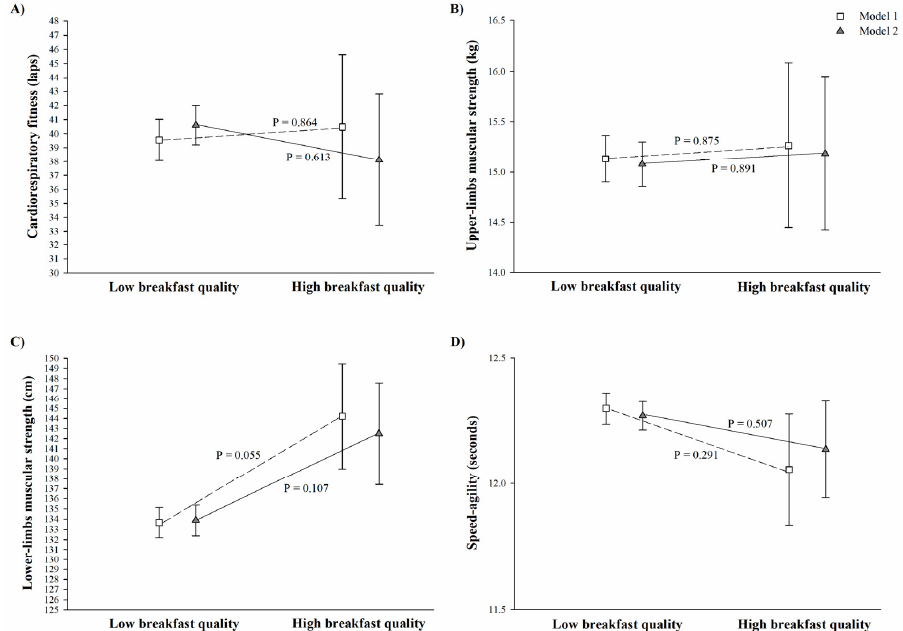
Figure 2. Differences between low and high breakfast quality and physical fitness components in children ( Panel A : cardiorespiratory fitness, Panel B : upper-limbs muscular strength, Panel C : lower-limbs muscular strength, and Panel D : speed–agility). lower-limbs muscular strength, and Panel D :